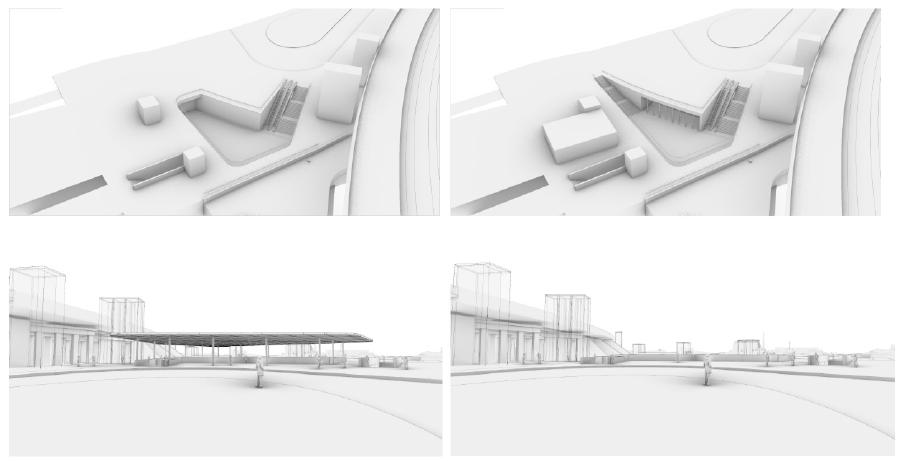
Figure 3. Geometrical studies of the NES concourse.